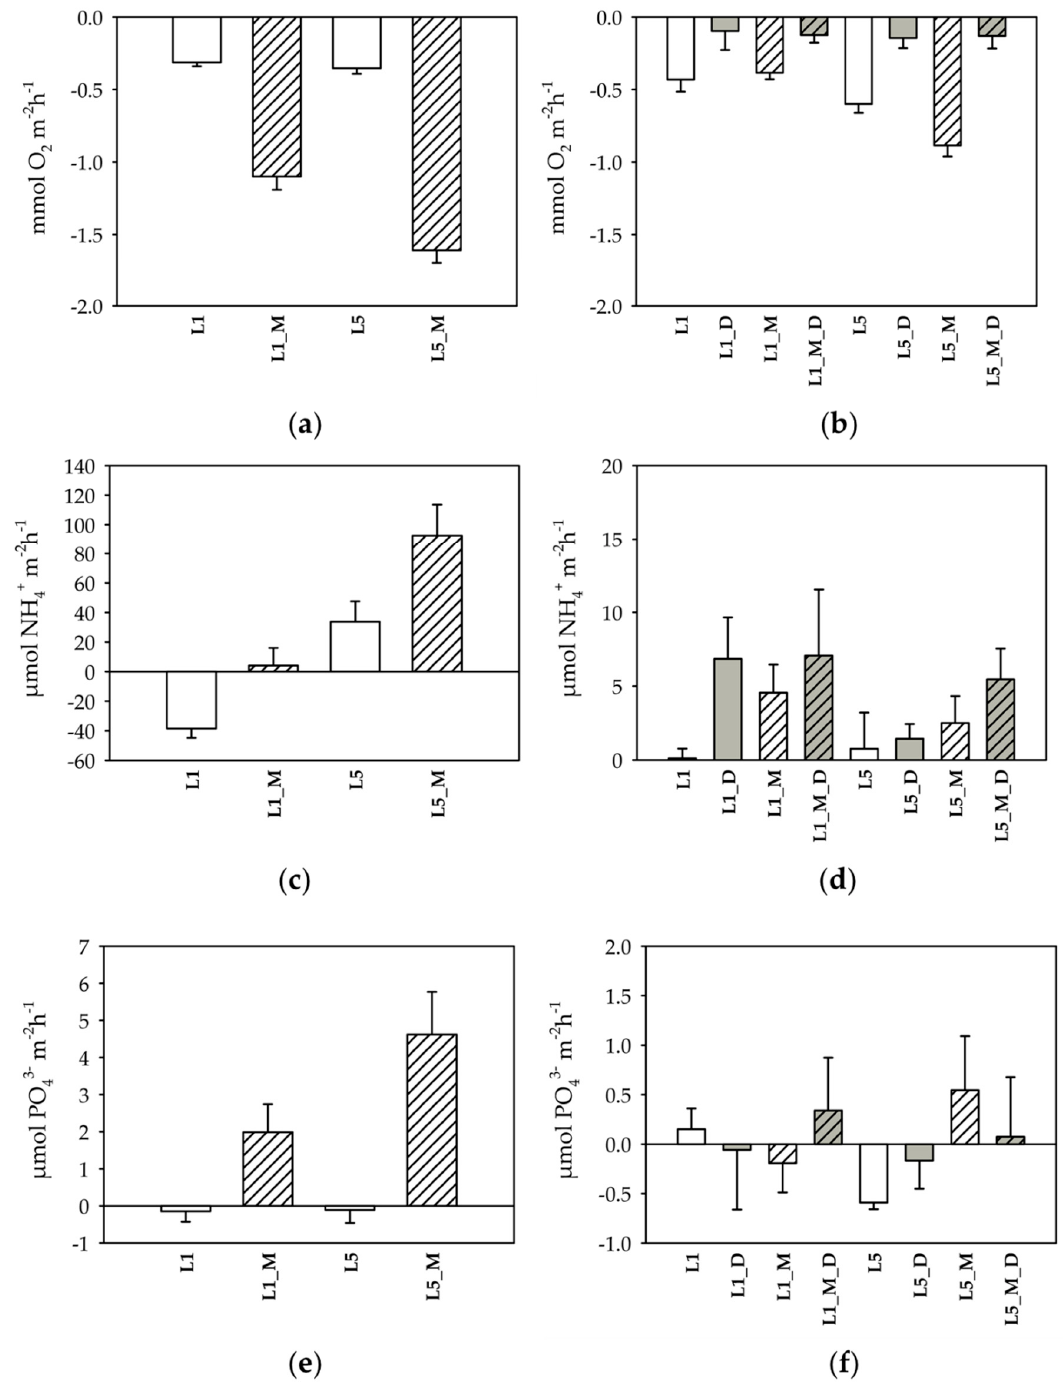
Figure 2. Dark net fluxes of O 2 ( a , b ), NH 4 + ( c , d ), PO 43 − ( e , f ) at day 5 ( a , c , e ) and at day 33 ( b , d , f ). Mean fluxes and standard error ( n = 10 at day 5 and n = 5 at day 33) of each condition are reported. All fluxes are expressed in µ mol m − 2 h − 1 or mmol m − 2 h − 1 . White bars represent the permanently submerged condition, grey bars represent dried conditions and hatched bars represent conditions with macrofauna.